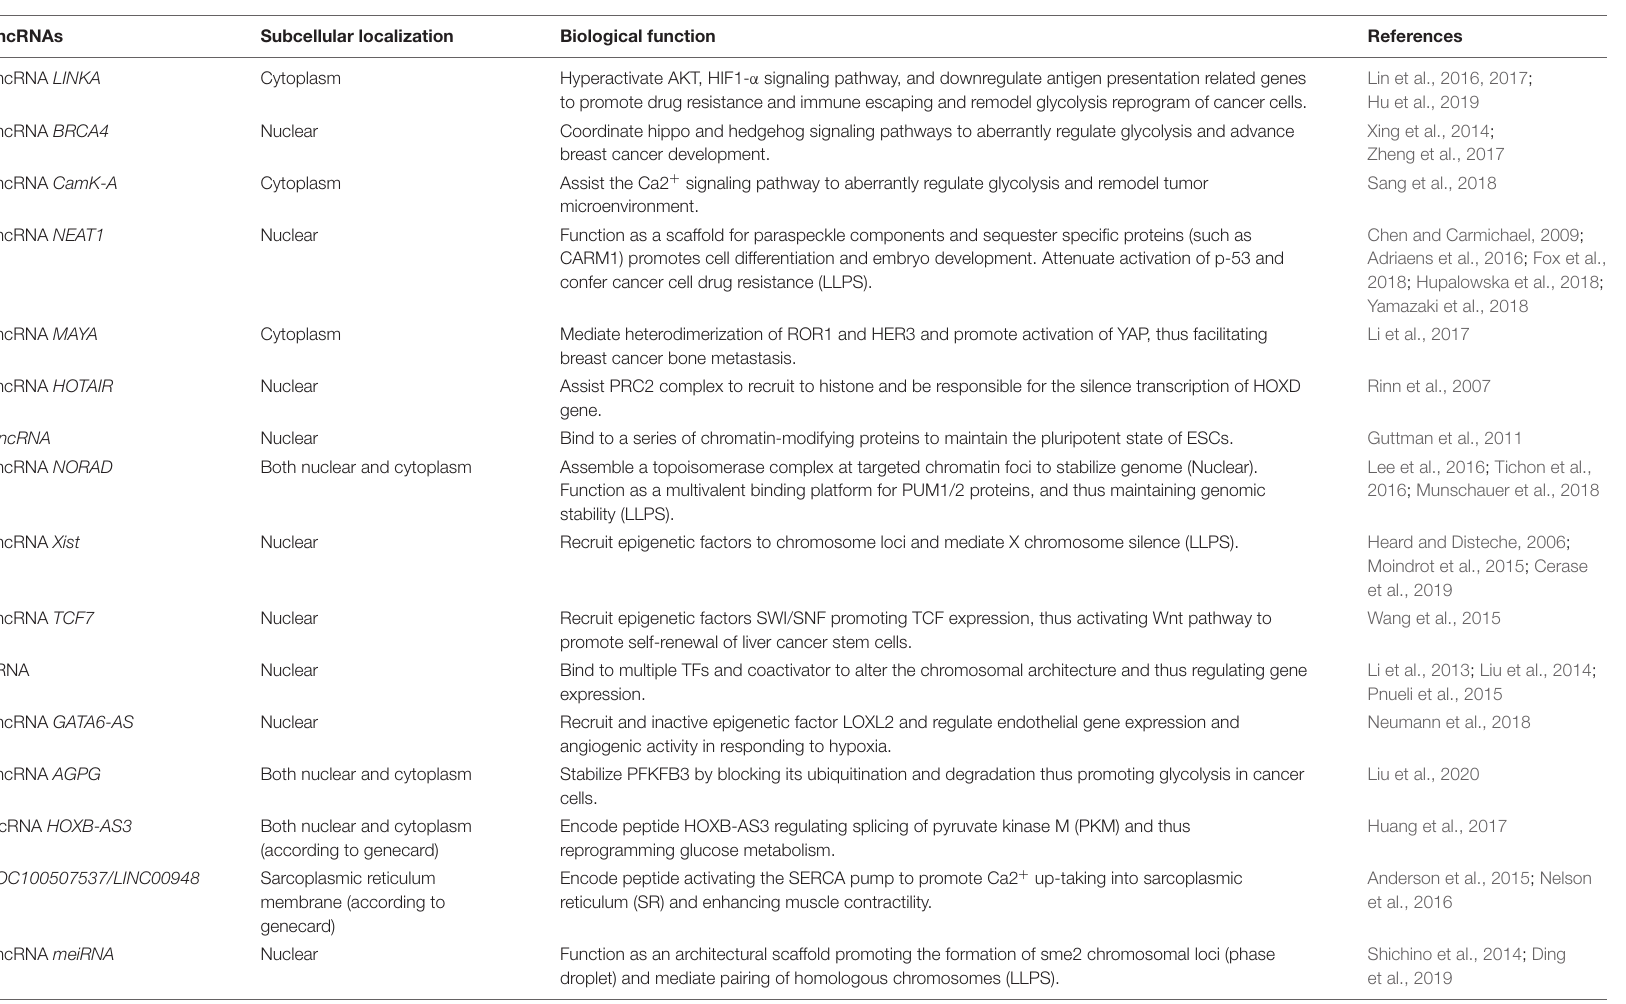
TABLE 1 | The LncRNAs referenced in this